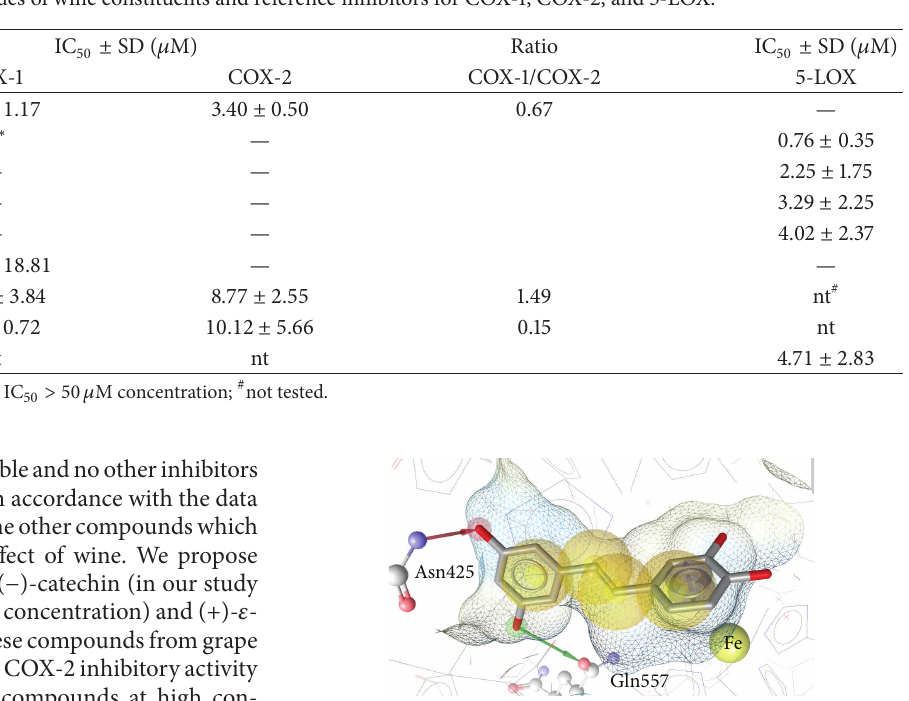
Figure 1: Docking pose of piceatannol in 5-LOX. Yellow spheres signify hydrophobic interactions with the binding pocket. The blue circle marks an aromatic interaction with the binding pocket. The green arrow signifies a hydrogen bond donor interaction with Gln557. The red arrow signifies a hydrogen bond acceptor interaction with